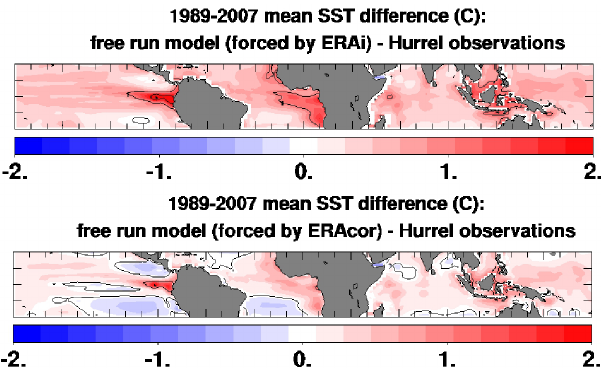
Fig. 11. 1989–2007 mean differences between Hurrel SST and free model run forced by ERAi (top), and between Hurrel SST and free model run forced by ERAcor (bottom) in the 20 ◦ N–20 ◦ S latitude